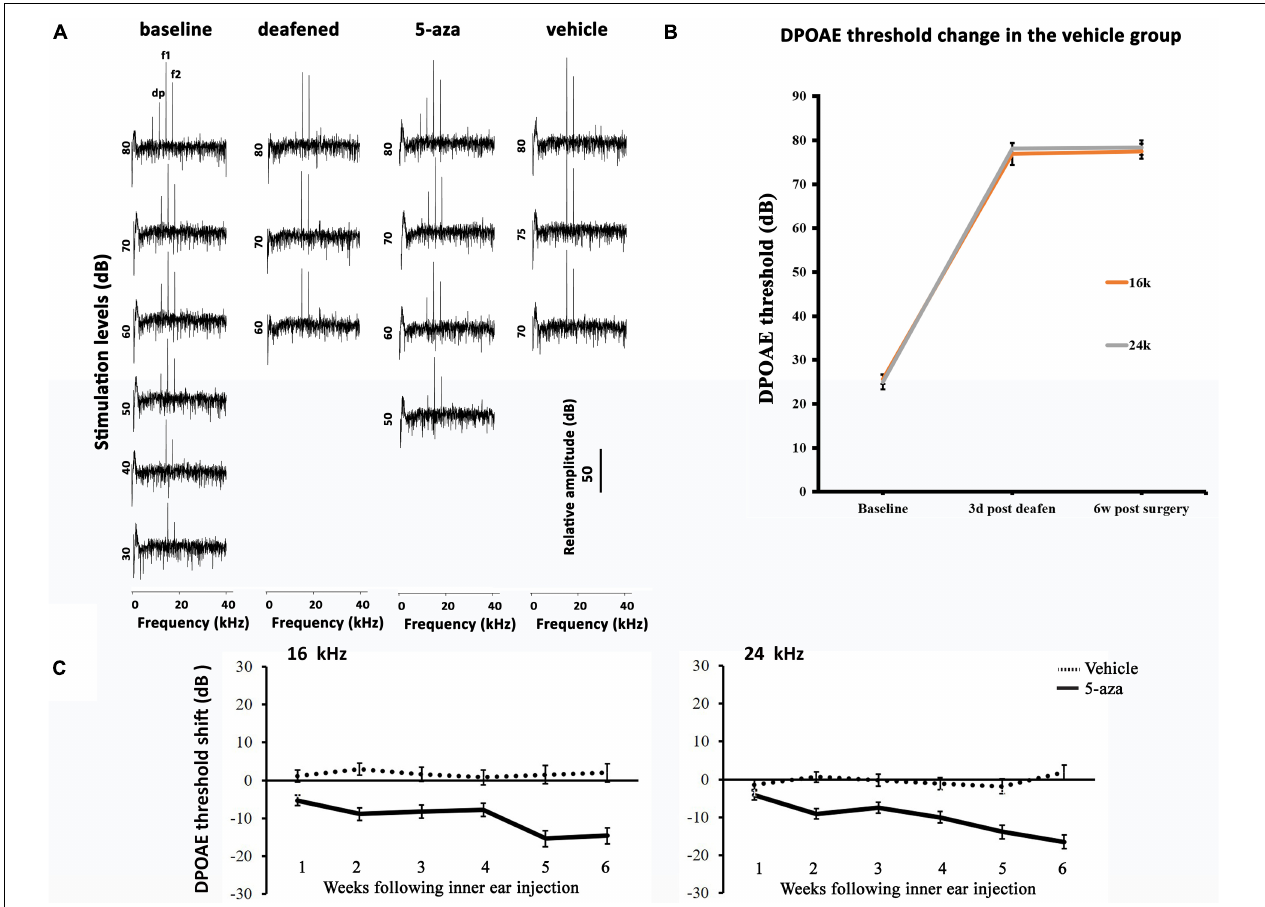
FIGURE 4 | Distortion-product otoacoustic emission (DPOAE) thresholds in the 5-aza- and vehicle-treated mice. (A) Representative DPOAE traces of 4 groups of mice. DPOAE threshold was determined by the lowest stimulation dB level that generates dp of at least 10 dB above the noise floor. The baseline threshold was 40 dB in this figure. Three days after deafening, DPOAE threshold was 80 dB. The 5-aza treated mouse showed 50 dB threshold 6 weeks after treatment, while the vehicle-treated mouse showed no DPOAE response 6 weeks after injection. (B) DPOAE threshold shifts were over 40 dB SPL 3 days after deafening in the saline group. The threshold shifts remained 6 weeks following deafening. (C) DPOAE threshold shifts trend for up to 6 weeks after surgery in the 5-aza and vehicle groups at 16 and 24 kHz. Negative values suggest hearing improvement. DPOAE threshold shifts in the vehicle group were close to zero, indicating that vehicle injection did not significantly change DPOAE threshold. Data are means ±